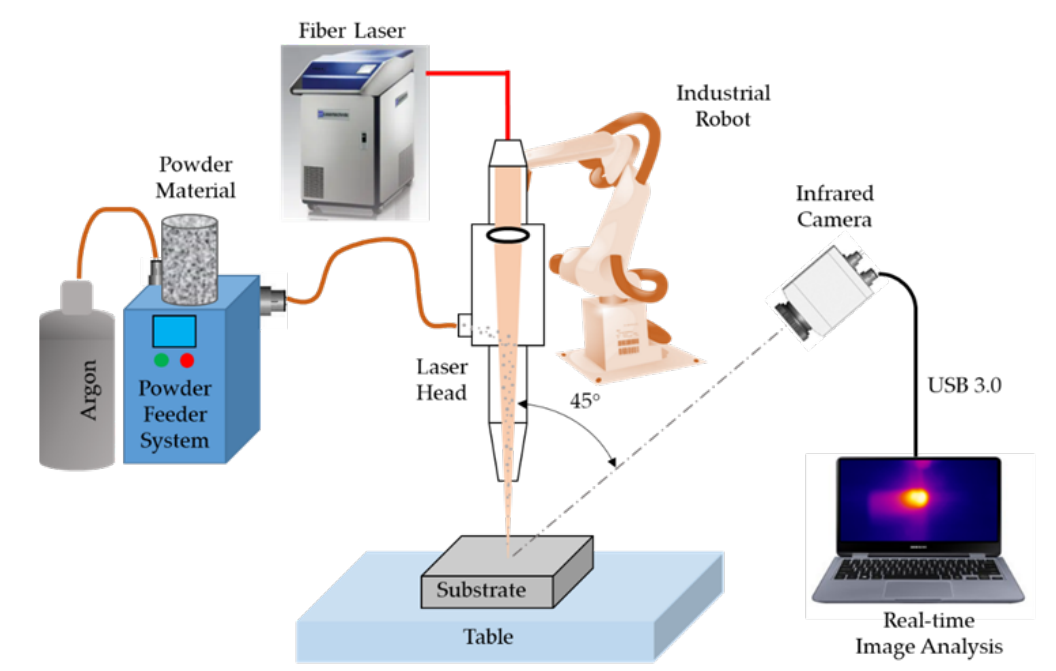
Figure 1. Experimental setup for process monitoring of laser cladding.